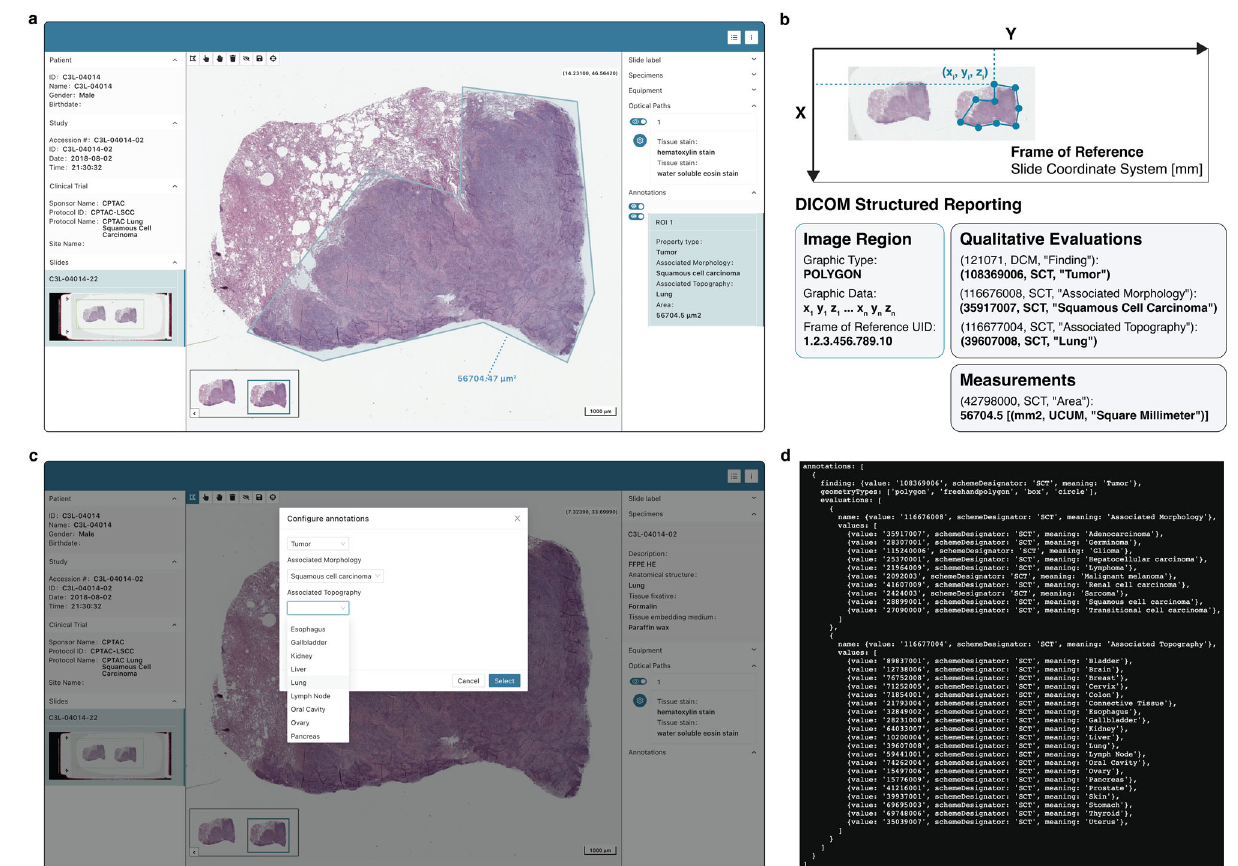
Fig.6|Annotationofimageregionsofinterest.a Annotationofimageregionsof interest (ROIs) using DICOM Structured Reporting. b Screenshot of the Slim user interface displaying a ROI annotation drawn by a user on images of the Clinical Proteomic Tumor Analysis Consortium (CPTAC) project. Note the user-provided qualitative evaluations and machine-generated size measurements of the ROI that are displayed in the side panel. c Screenshot of the Slimuser interface displaying